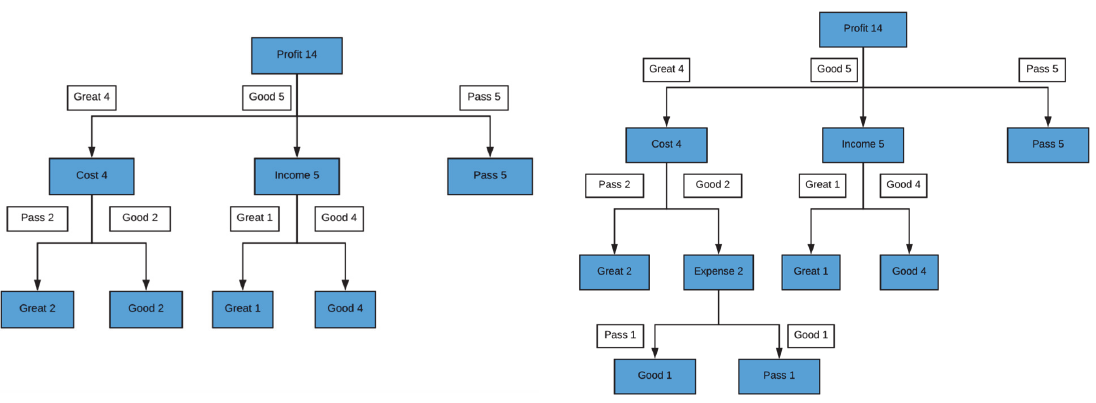
Fig. 6. Decision Tree Fig. 7. Decision